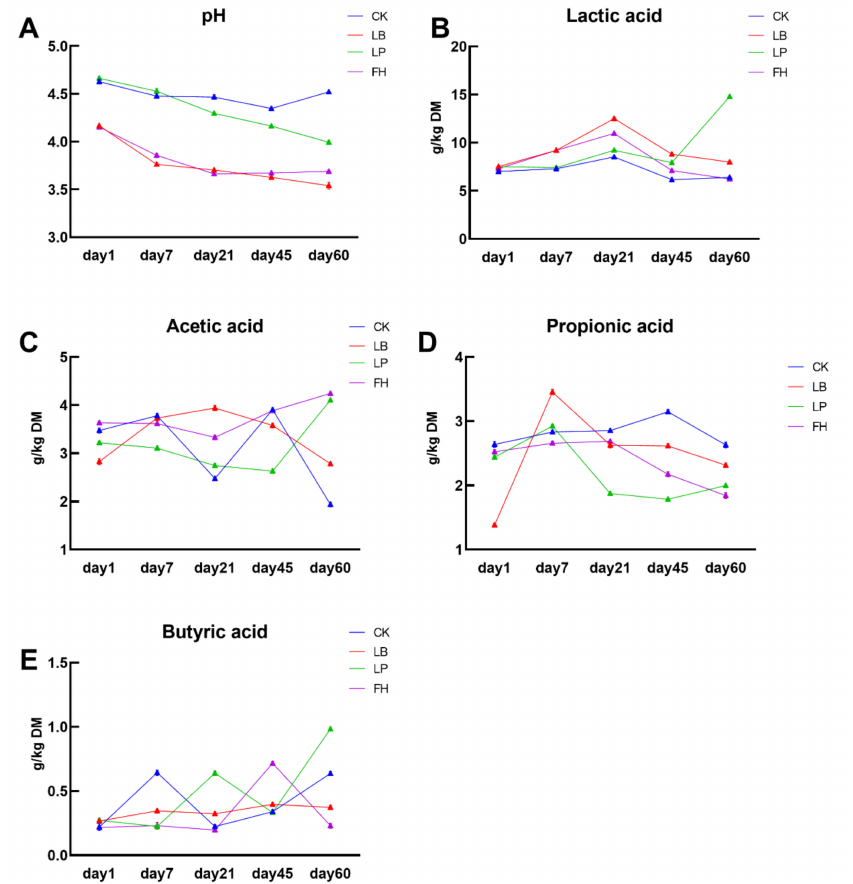
Figure 1. Changes in fermentation quality of M. aquaticum silage during ensiling. ( A ) pH value; ( B ) lactic acid content; ( C ) acetic acid content; ( D ) propionic acid content; and ( E ) butyric acid content. CK, control; LB, Lactobacillus buchneri ; LP, Lactobacillus plantarum ; and FH, combination of LB and